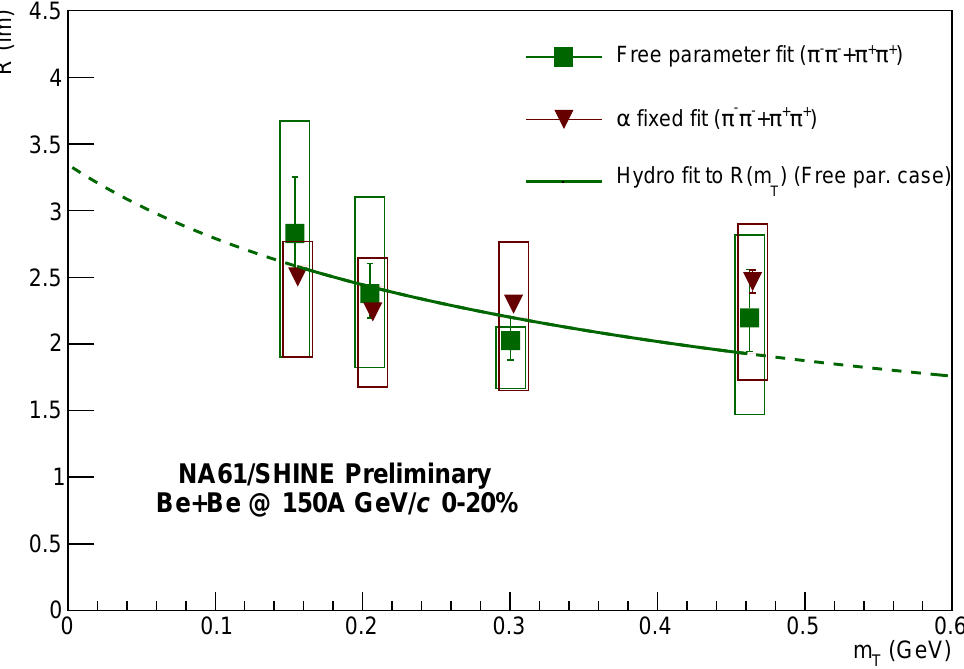
Figure 3. Correlation strength R versus transverse mass: comparison between free parameter fit, fit with α fixed and fit with R fixed. The boxes represent systematic uncertainties. For each bin, the results are slightly shifted to the right for visibility, but they are in the same bin.